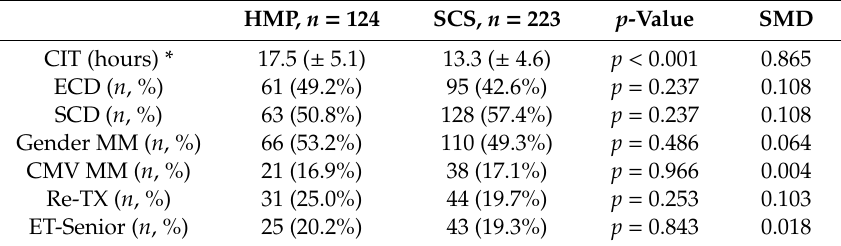
Table 1. Baseline characteristics of the unmatched kidney transplant cohort ( n =